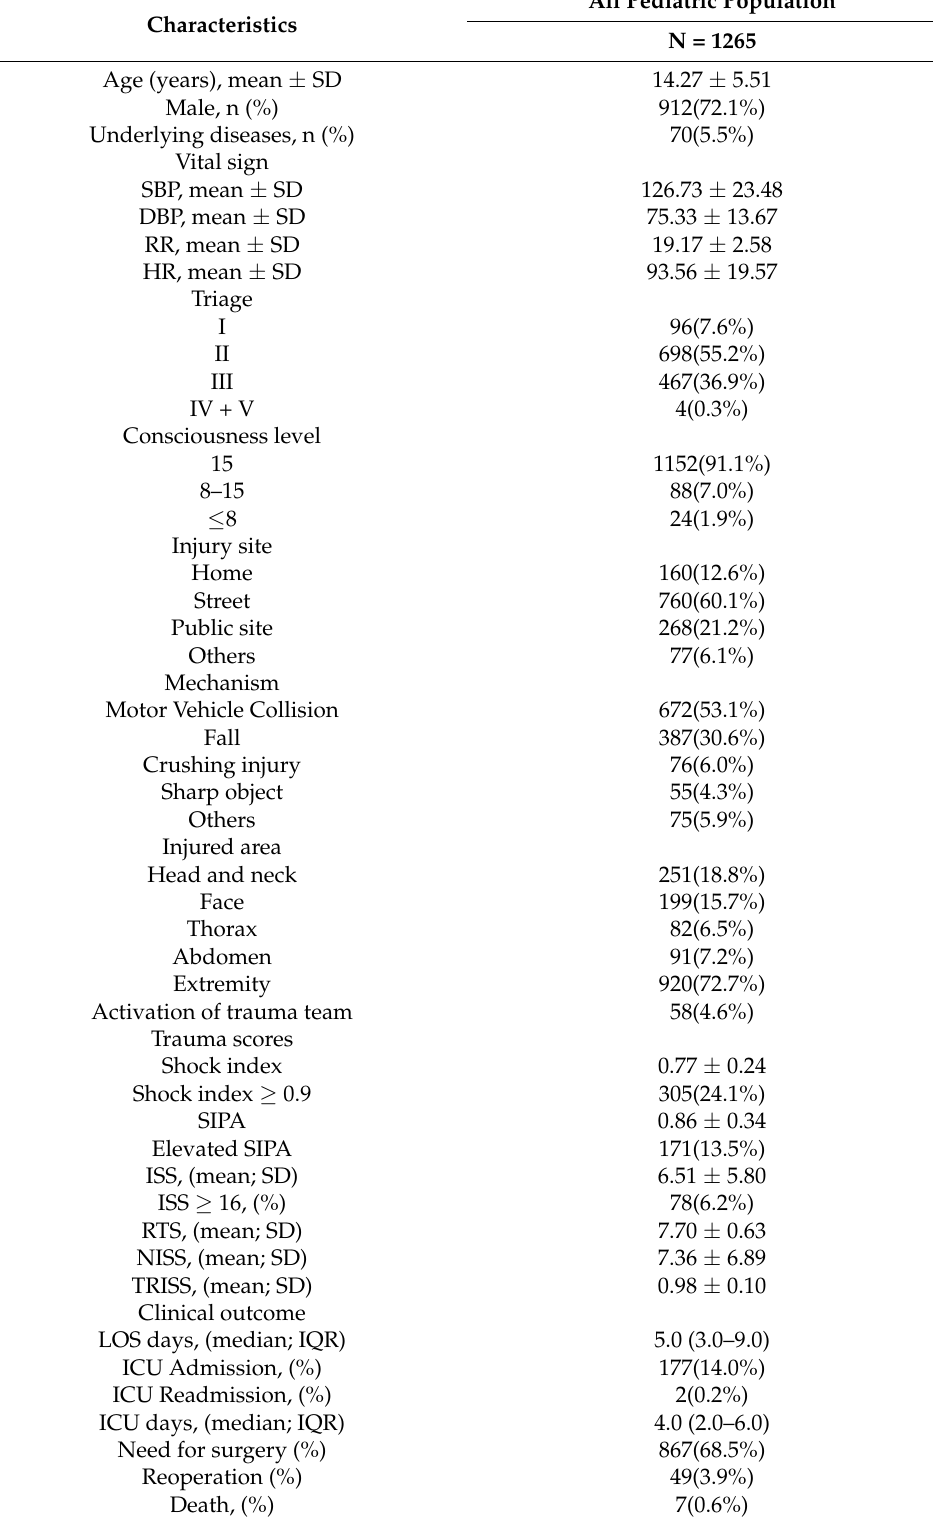
Table 2. Demographic population of all pediatric trauma